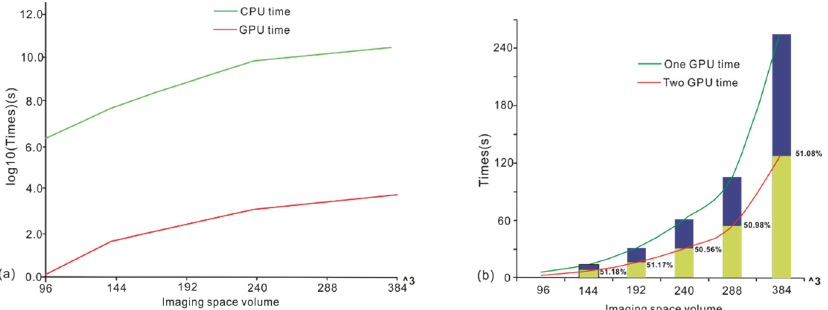
Figure 10. Comparison between the computing efficiency of ( a ) a single CPU and a single GPU; ( b ) comparison between computing time of a single GPU and dual GPU.